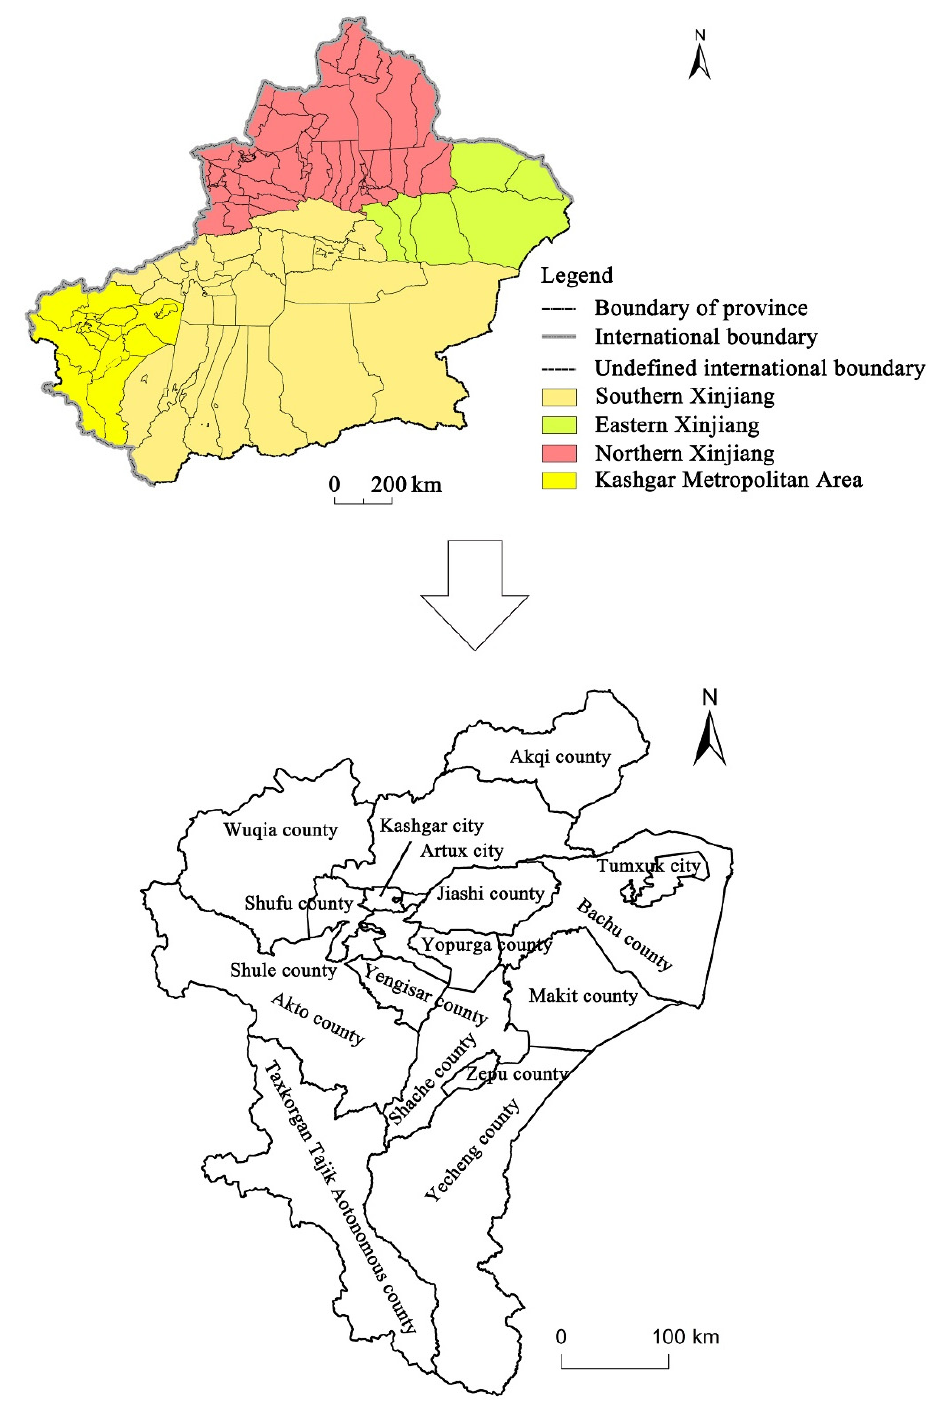
Figure 3. The location of KMA in China. ( Note: the image is based on the standard map GS (2019) No. 1652 of the standard map service website of the Ministry of Natural Resources of China; the base map boundary has not been modified).